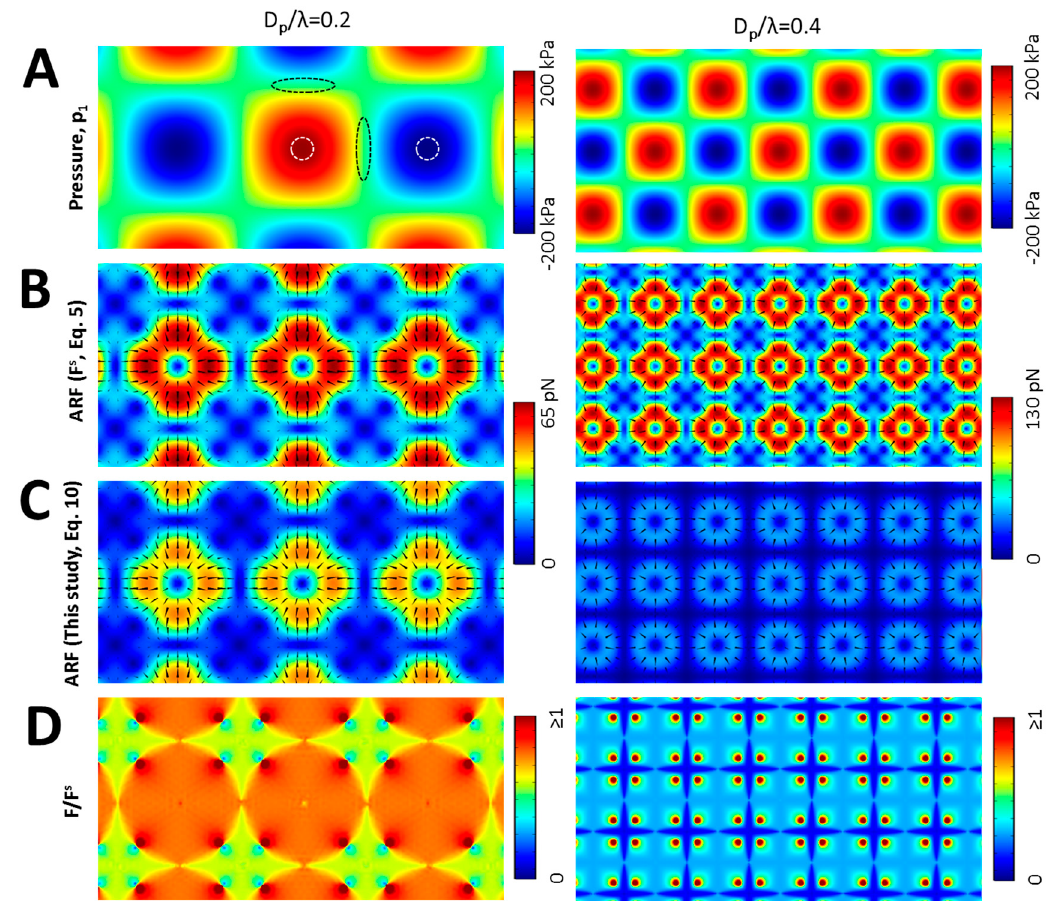
Figure 5. Evaluation of the ARF arising from perpendicular acoustic waves field with D p / λ = 0.2 and 0.4. ( A ) Instantaneous acoustic standing pressure map. Ellipses between positive and negative pressure areas show typical pressure nodes while circles indicate typical pressure anti-nodes; ( B ) The ARF calculated using small particle assumption. Triangles show the force direction; ( C ) The calculated ARF where the BP size is considered in equations. The results demonstrate that not only the values of actual ARF are significantly lower in comparison with previous analytical approaches but also its pattern is different particularly in higher frequencies; ( D ) The deviation of previous ARF calculations with respect to the position in standing pressure field. The variable F / F s implies that F s cannot be amended by a constant modifying factor for multidirectional acoustic fields.